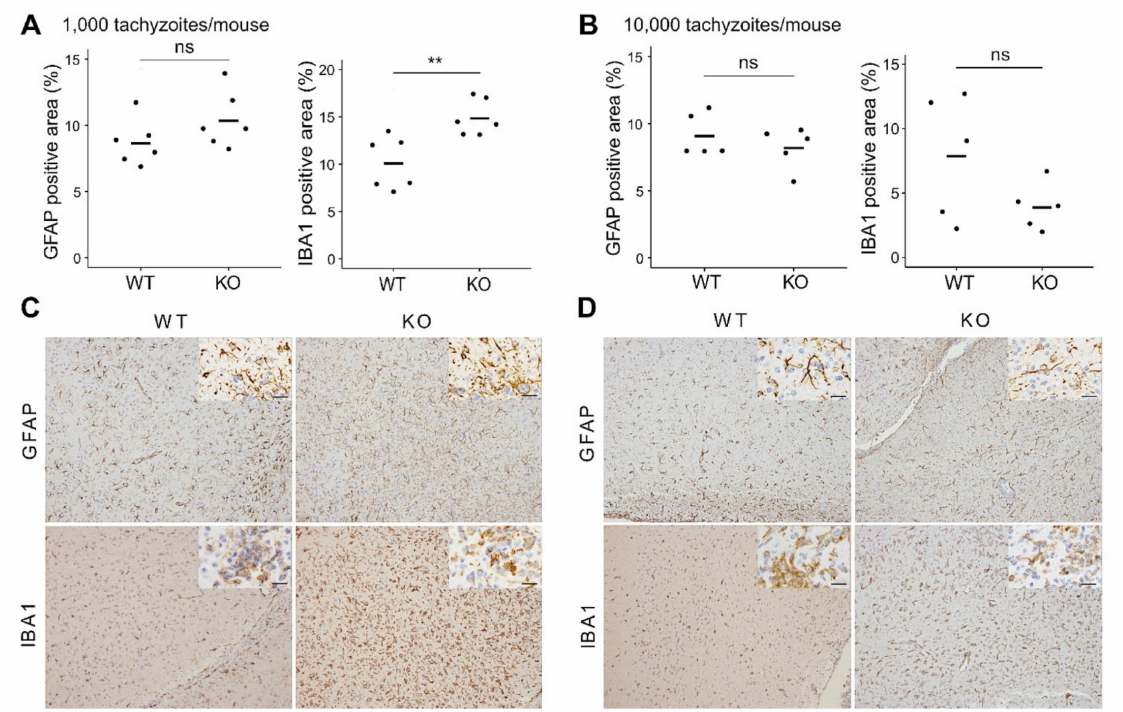
Figure 2. Astrocyte and microglia populations in the frontal lobes of T. gondii -infected mice. The brains from WT and CXCR3KO mice surviving at 60 dpi were subjected to histopathological processing. Astrocyte and microglia populations were identified using immunohistochemical staining against glial fibrillary acidic protein (GFAP) and ionized calcium- binding adapter molecule 1 (IBA1), respectively. ( A , B ) Positive areas were compared between WT and CXCR3KO. Horizontal bars represent the mean value. ns, p > 0.05; ** p < 0.01, two-tailed unpaired Student’s t -test. ( C , D ) Representative immunohistochemical images were taken from serial tissue sections containing both astrocytes and microglia. ( A , C ) 1000 tachyzoites per mouse ( n = 6 per group). ( B , D ) 10,000 tachyzoites per mouse ( n = 5 per group). Magnified images were shown in the top right of each picture of astrocytes and microglia. Scale bars, 20 µ